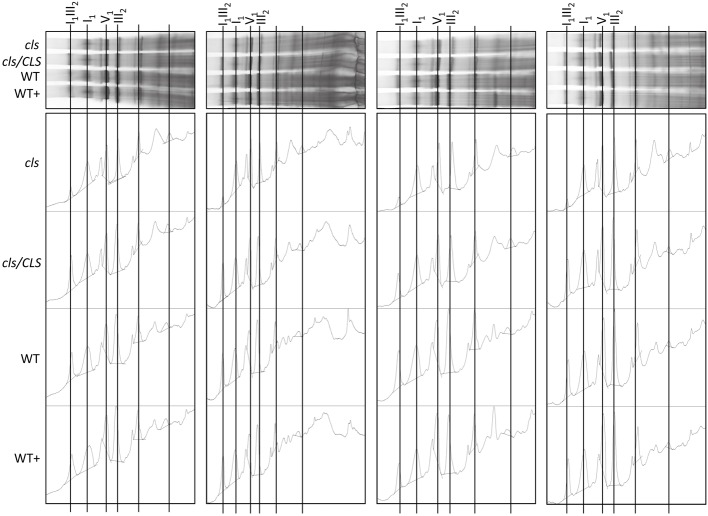
Abundances of respiratory complexes and supercomplex of four biological replicates in digitonin solubilized mitochondria of cls, cls/CLS, WT, and WT+ lines. Complexes were separated on 1D BN gels (top) and protein abundances subsequently assessed using the gel analysis option in the imageJ software (lower).